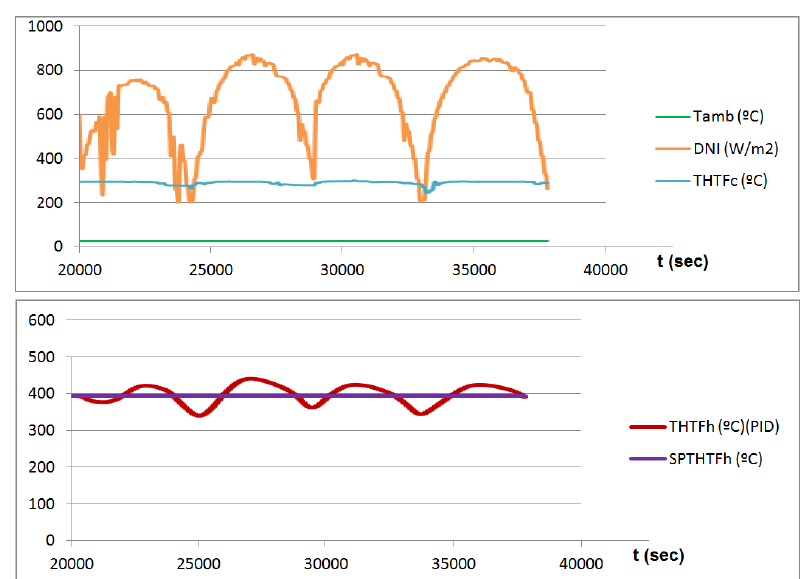
Figure 21. PID controller response to July 2013 values.